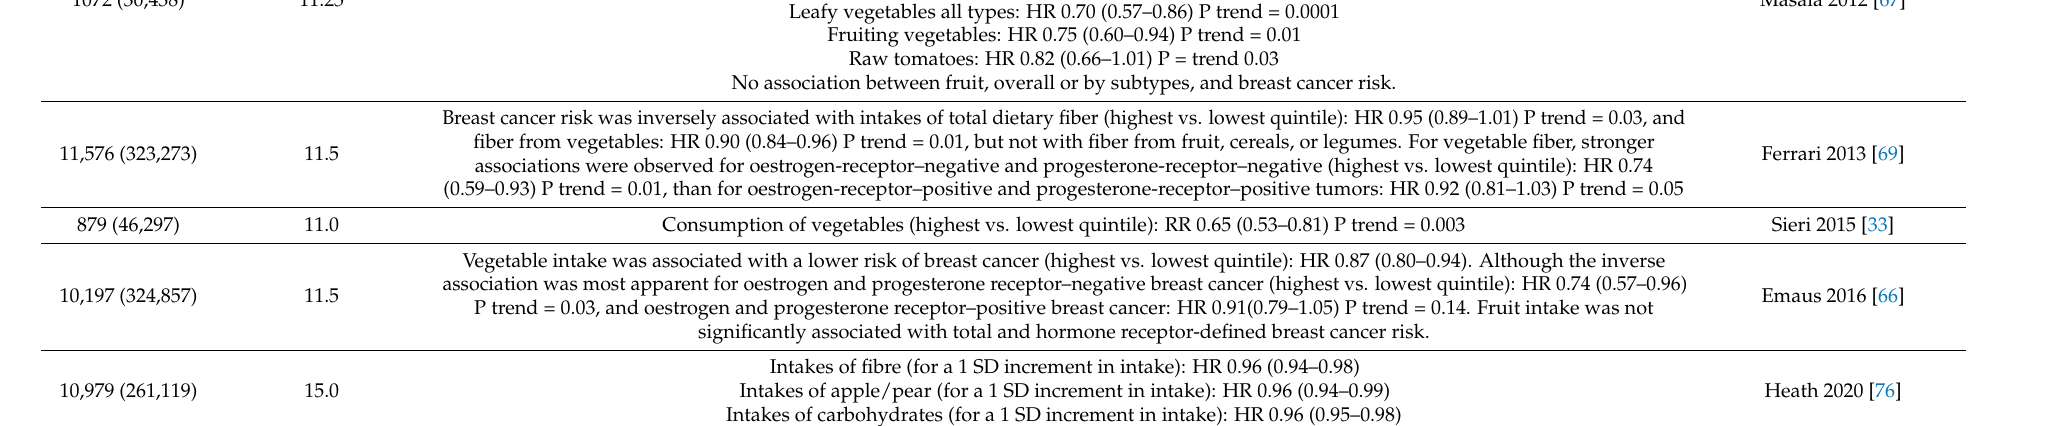
receptor-negative tumors. Inverse association between consumption of all vegetables and breast cancer risk (highest vs. lowest quintile): Vegetables (all types): HR 0.65 (0.53–0.81) P trend = 0.003 According to subtypes of vegetables, inverse association between increasing consumption of leafy vegetables, fruiting vegetables and raw tomatoes (highest vs. lowest quintile): Leafy vegetables all types: HR 0.70 (0.57–0.86) P trend = 0.0001 Fruiting vegetables: HR 0.75 (0.60–0.94) P trend = 0.01